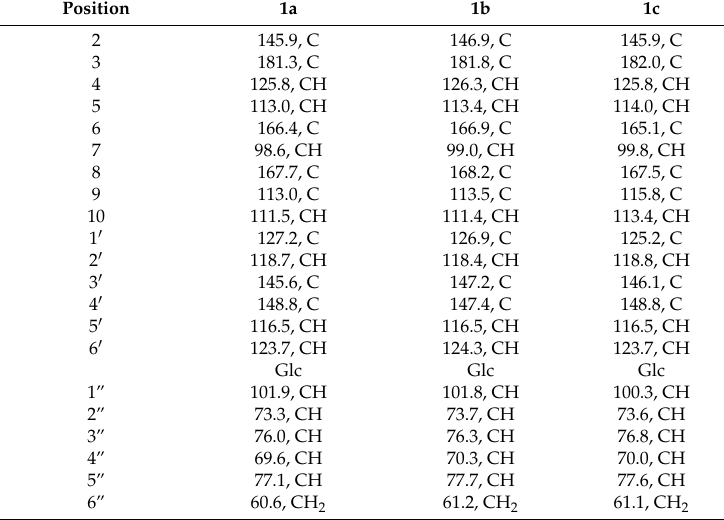
Table 2. 13 C NMR (150 MHz) spectroscopic data ( δ in ppm) for compounds 1a ~ 1c in DMSO- d 6 . Position 1a